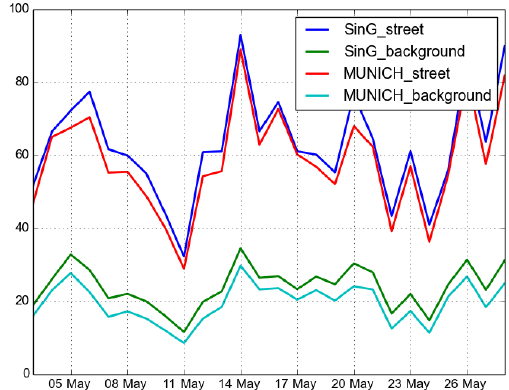
Figure 15. NO 2 daily average concentrations (µgm − 3 ) in the street and in the background using MUNICH (one-way dynamic cou- pling) and SinG (two-way dynamic coupling) at CELES traffic sta-